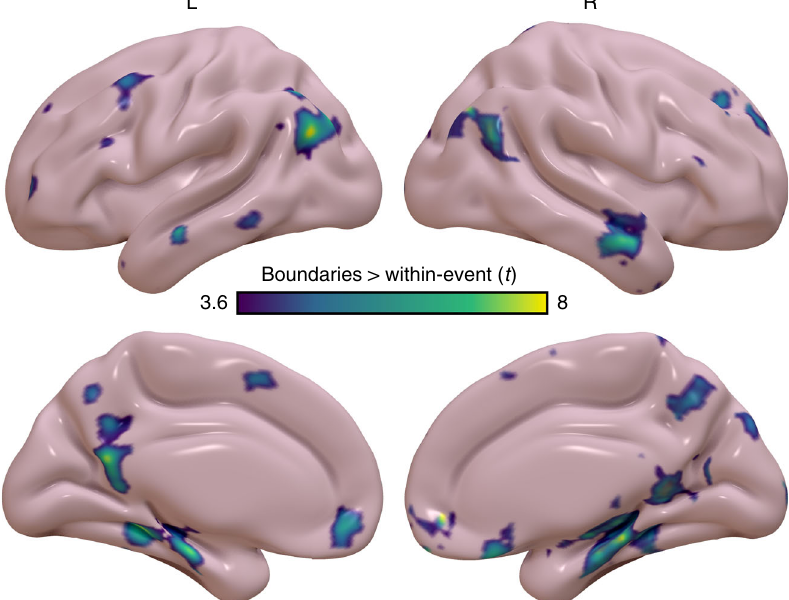
Fig. 7 Voxelwise analysis of boundary-evoked activity versus within-event activity. Greater boundary-evoked activity than within-event activity is observed throughout the hippocampus and PM network, consistent with ROI-based analyses. Signi fi cance is evaluated at a corrected FDR threshold of q <